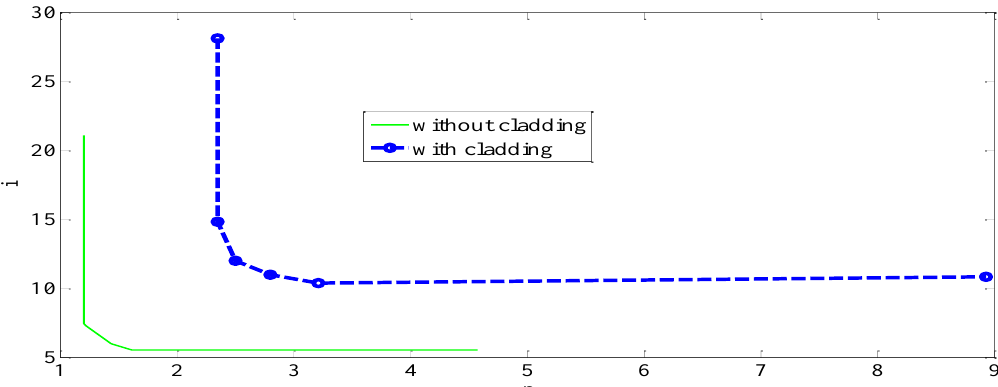
Fig. 19. Non dimensional parameter pi diagrams of the structures without and with cladding material for Blast load acting on roof (19)